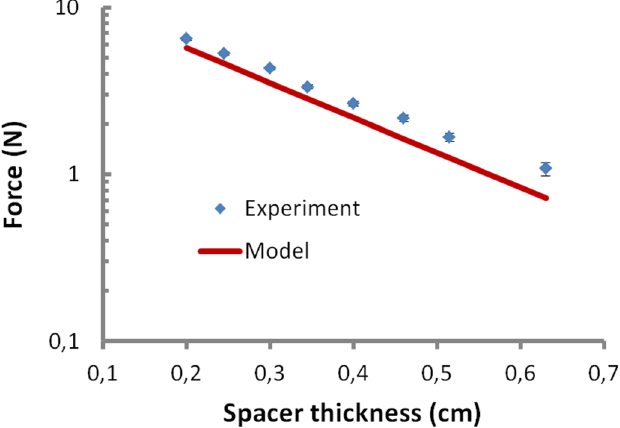
Fig. 8. Force exerted by the magnet on the steel ball as a func- tion of separation. The model is obtained from the derivative of the potential well function (Figure 7 red line). Experimental data obtained by an experimental procedure is described in Figure 9. The straight line in the log scale in both cases evidences the quadratic nature of the